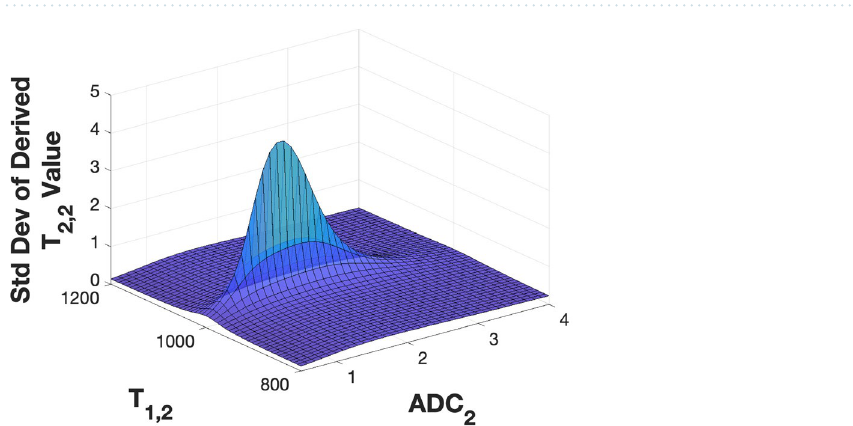
Figure 9. Results of linearized analytical calculation of the SD of recovered values for T 2,2 in the biexponential 3D model, as a function of indirect dimension parameters , with other parameters fixed at c 1 c 45 ms , T 2,2 60 ms , T 1,1 1000 ms , and ADC 1 0.7 , T 2,1 1.5 mm 2 /ms. The SD values are obtained 2 = = = = = from the square root of the corresponding diagonal elements of the covariance matrix defined by Eq.